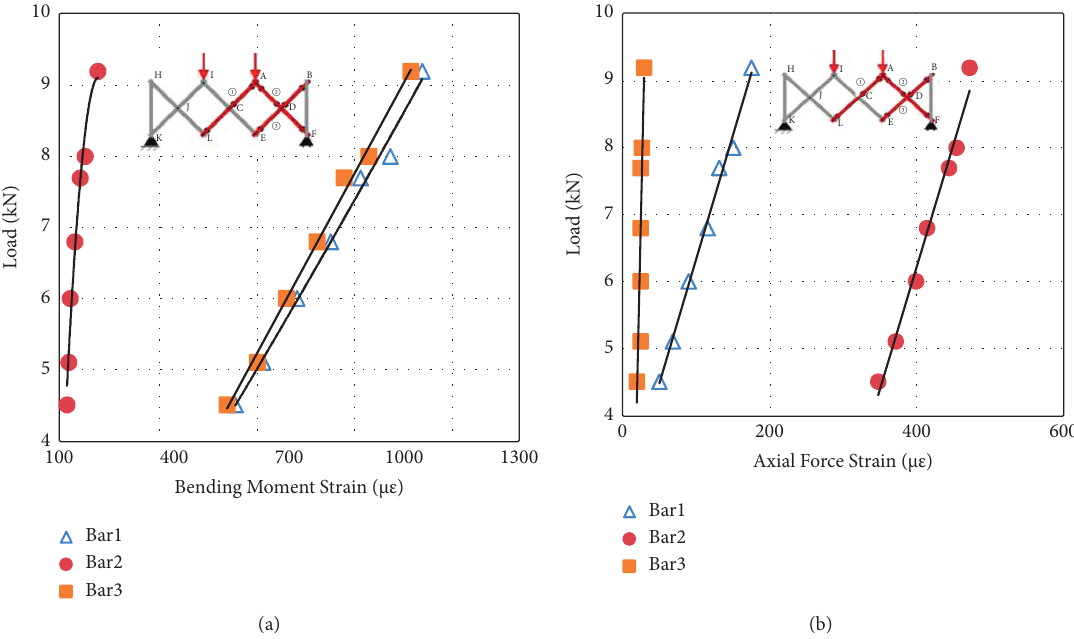
Figure 13: Load-strain curve of bar 1 of the cable-strengthened structure: (a) load-bending strain curves and (b) load-axial strain curves. Table 2: Comparison of bending strain and axial strain of bar 1 of the cable-free scissor structure. Load